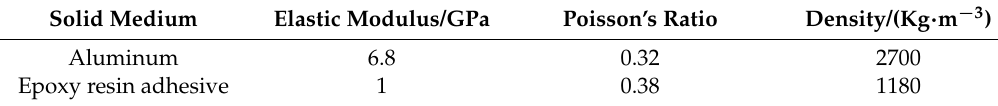
Table 3. The material properties of solid domain.